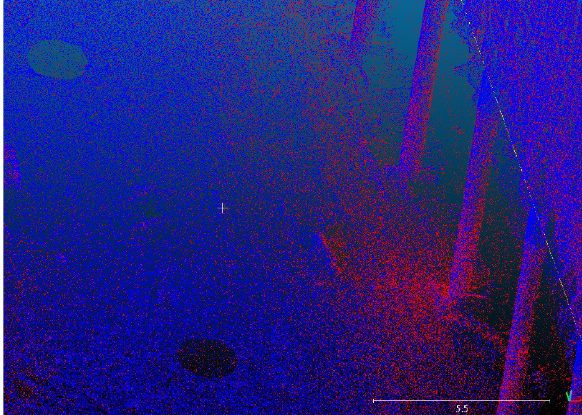
Figure 7 . (a) Red: Zeb Horizon Point Cloud of the railway station (partial) (b) Blue: TLS scans – May 2022 survey.